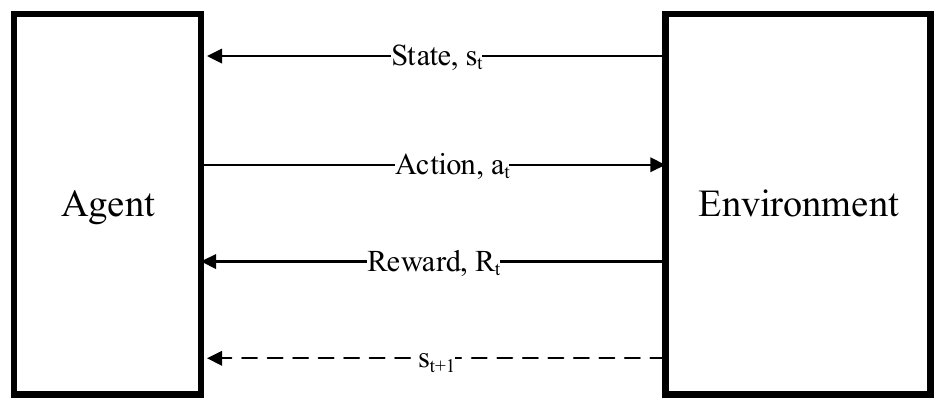
Figure 1. The schematic map of RL (the solid lines represent that the state, action and reward are generated from current timestep t , the dotted line of s t + 1 is obtained from the next timestep t + 1